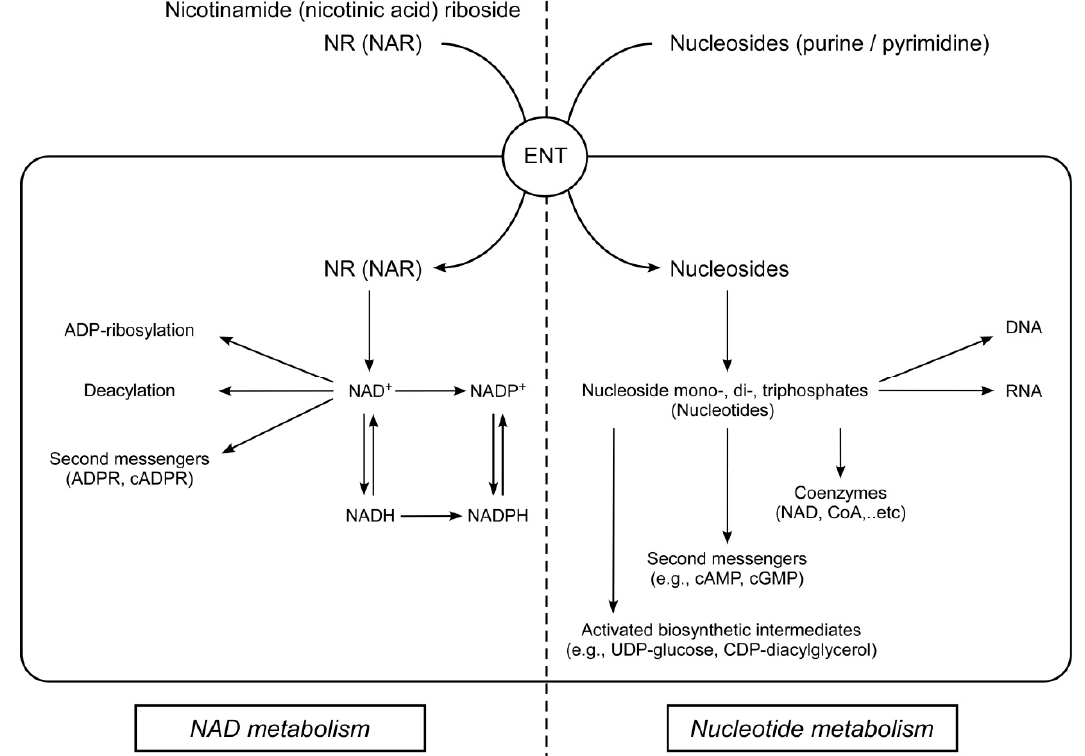
Figure 6. Human ENTs mediate cellular uptake of various nucleosides required for the synthesis of NAD(P) + or their mono-, di-, and triphosphates needed in all branches of metabolism and signaling.